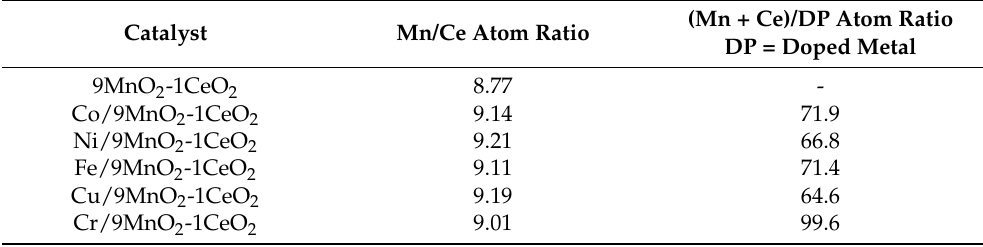
Table 2. Catalyst component content analysis from